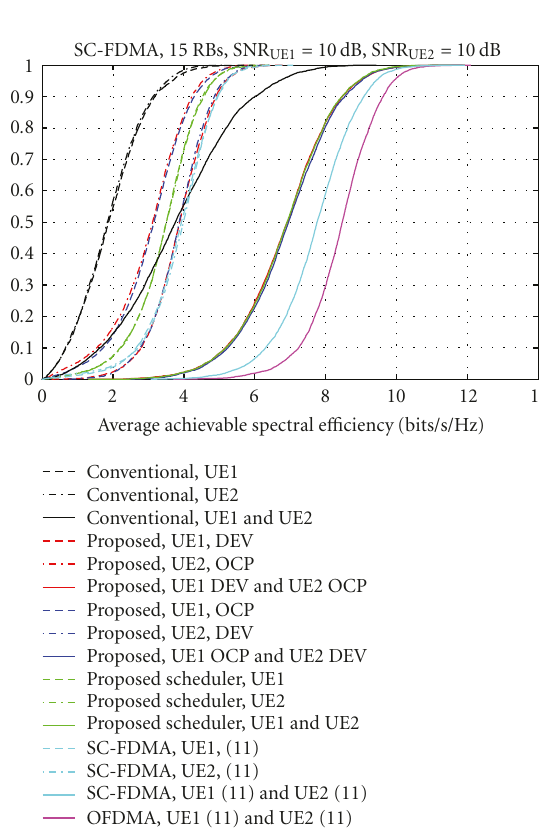
Figure 6: Cumulative distribution function (CDF) of the achiev- able spectral e ffi ciency by using conventional virtual MIMO with a single antenna per UE (black) and by using a spatial precoder according to Figure 2 with fixed optimization order (red and blue) and a spatial scheduler (green) for an SC-FDMA system ( β = 1). For reference, the case that both UEs use frequency-dependent precoding according to (11) is included for the SC-FDMA system (cyan) and for the OFDMA system (magenta). 15 RBs are available in the system and both UEs have the same average received SNR of